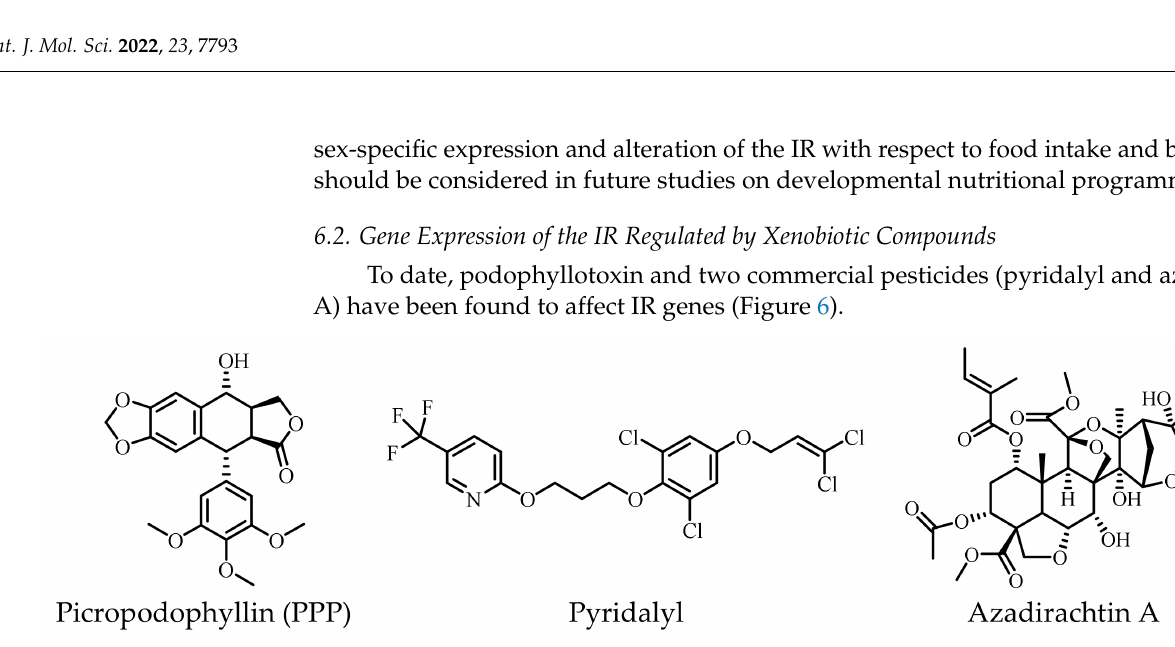
Figure 6. Structures of xenobiotic compounds regulating IR